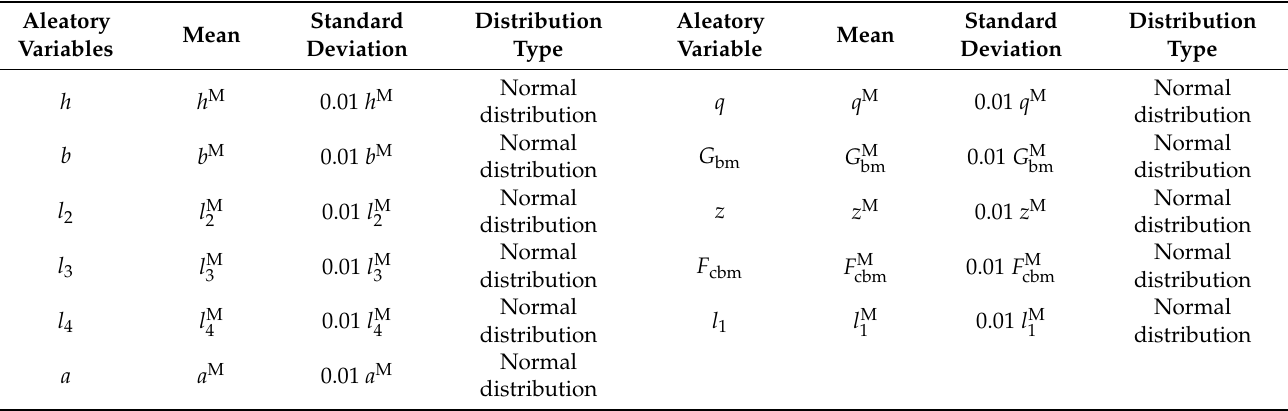
Table 2. Uncertainty description of each aleatory variable in the rotor mechanism design optimiza- tion problem.